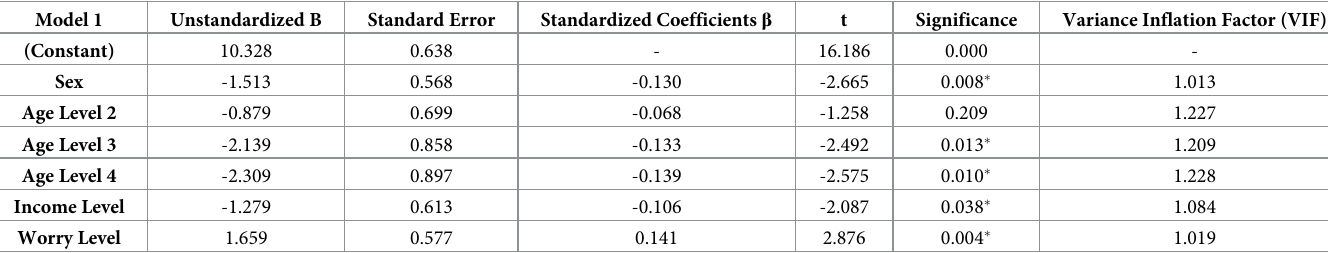
Table 4. Multiple regression analysis on how categorical variables predict insomnia ( � p < 0 . 05 ). Model